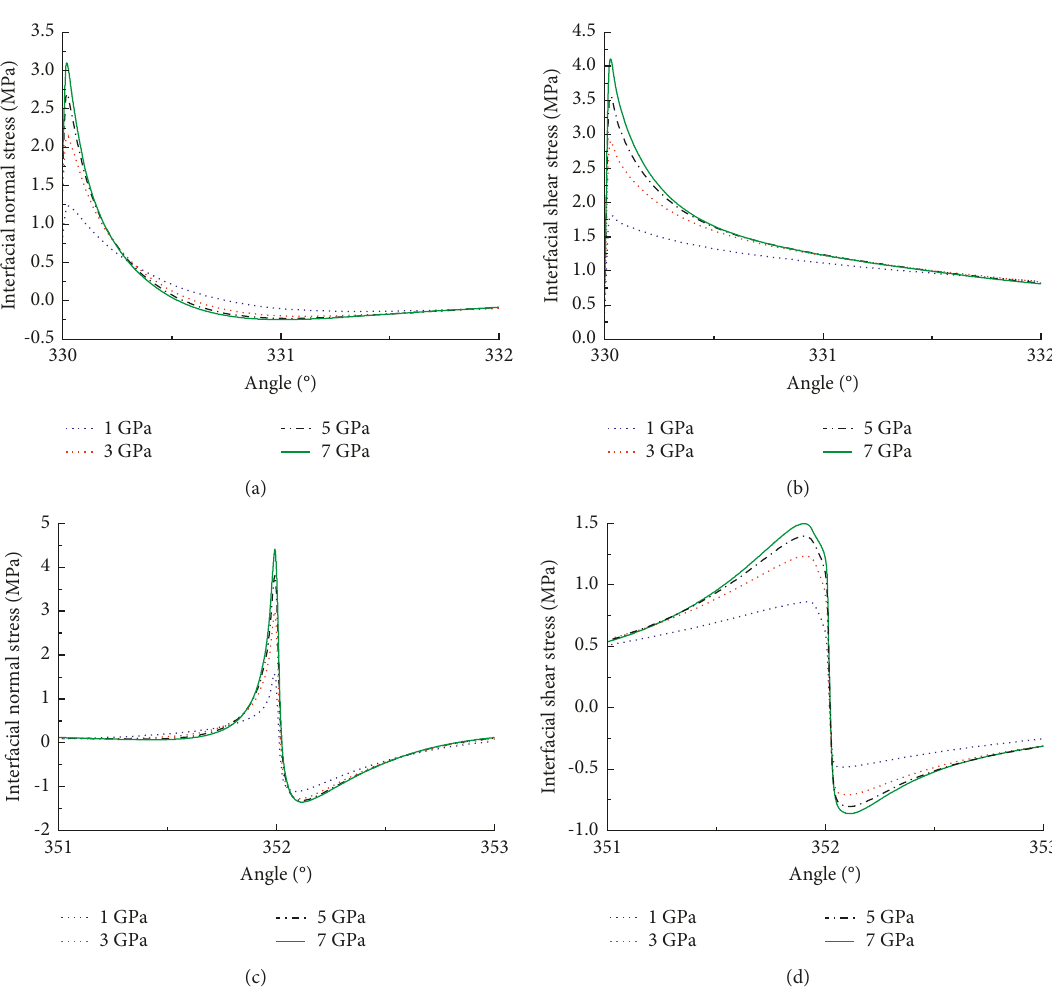
Figure 16: Interfacial stresses under adhesive layers with different elastic modules. (a) Normal stress near plate end. (b) Shear stress near plate end. (c) Normal stress near 352 ° joint. (d) Shear stress near 352 °